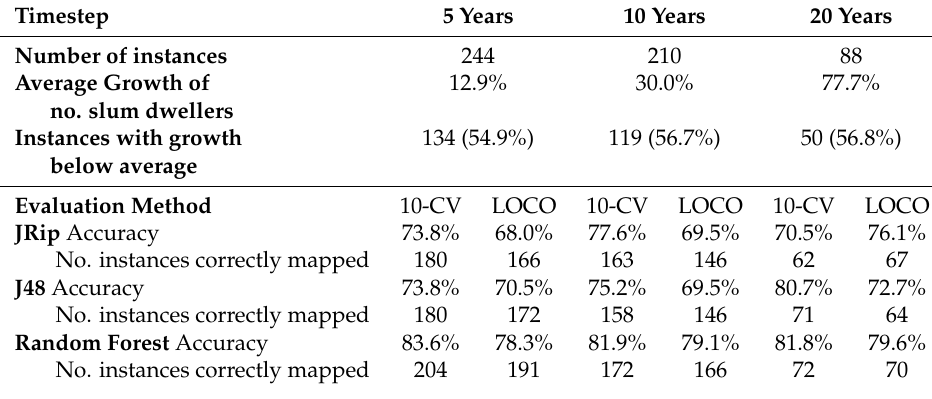
Table 3. Evaluation of the different classification methods for predicting slum growth over